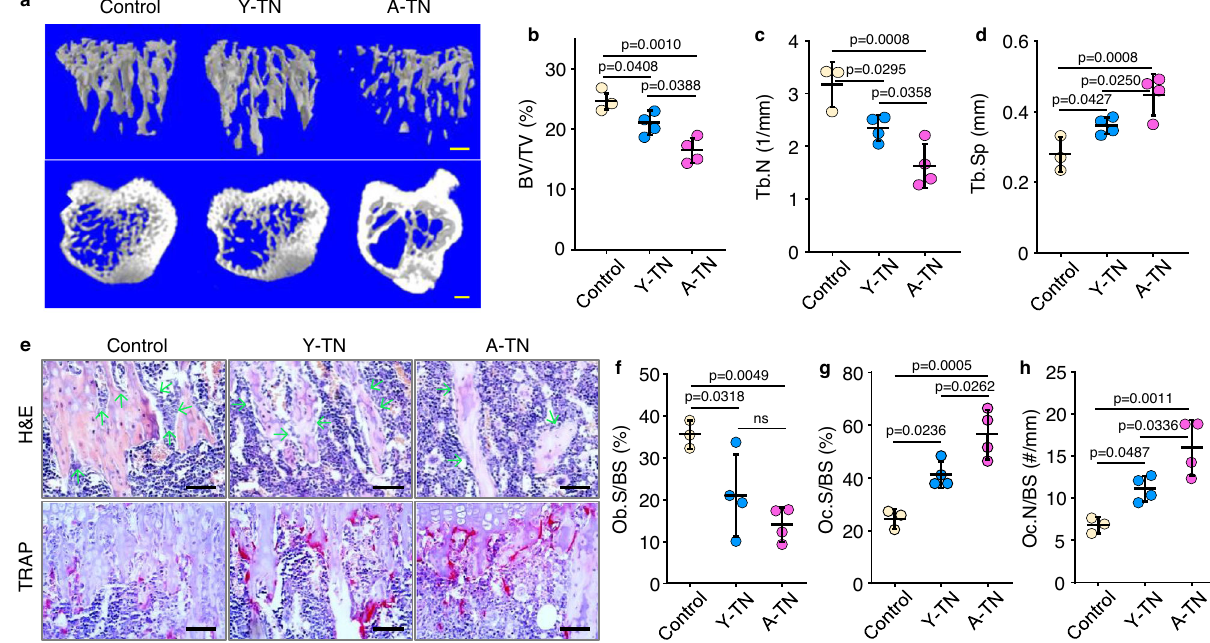
Fig. 3 | NSG mice injected with TGF β 1-expressing neutrophils (TNs) develop osteoporosis.a μ CT3D reconstructionof trabecularboneand coronalsectionsof tibial metaphyses ofNSG mice injected with PBS (control), TNs sortedfrom young (Y-TN) or from aged mice (A-TN). Bar=1mm. b – d Microstructural parameters, including trabecular bone volume (BV/TV) ( b ), number (Tb.N) ( c ), and separation (Tb.Sp)( d )intibialmetaphyses.Mean±SD( n =3,4,and4biologicallyindependent male recipient mice for control, Y- and A-TN groups, respectively).